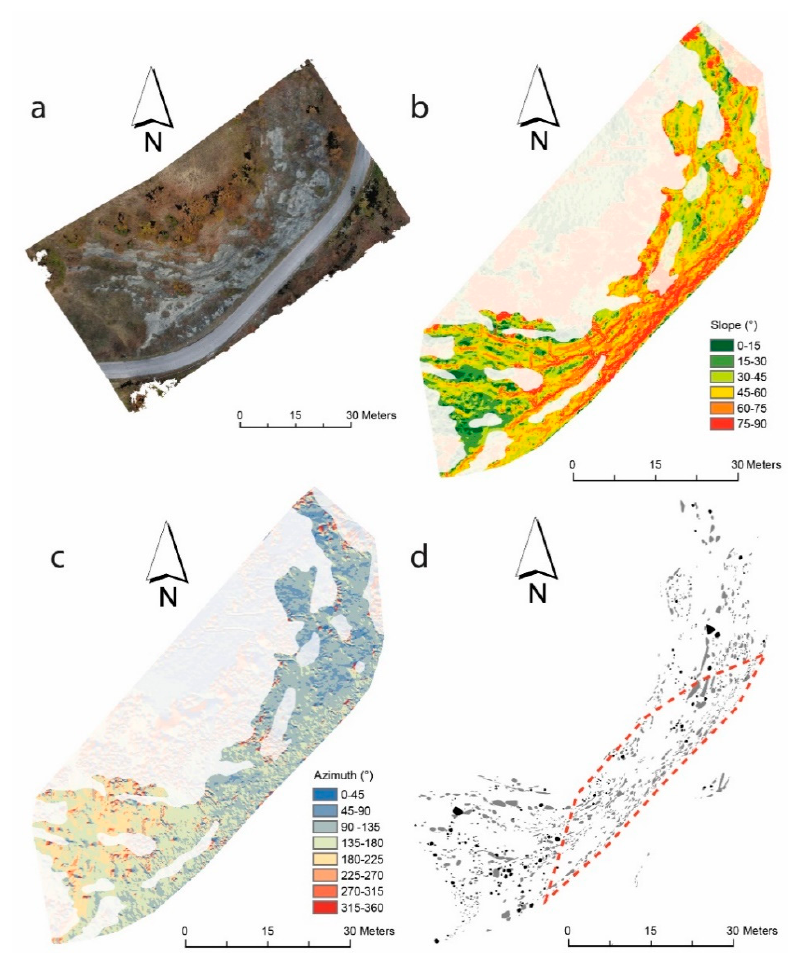
Figure 5. ( a ) View from above of the point cloud with outlines of the two outcrop faces used for computing concretion pattern spatial statistics; ( b ) Slope direction and ( c ) slope angle of the digital surface model obtained from the point cloud. The transparent white polygons represent poor outcrop exposure or covered areas; ( d ) Concretion boundaries extracted from the VRGS software and used to assess width-to-length (black) and thickness-to-width (grey) ratios. The dashed red polygon highlights the near vertical outcrop face used for evaluating the spatial clustering of concretions (see Section 3.3).